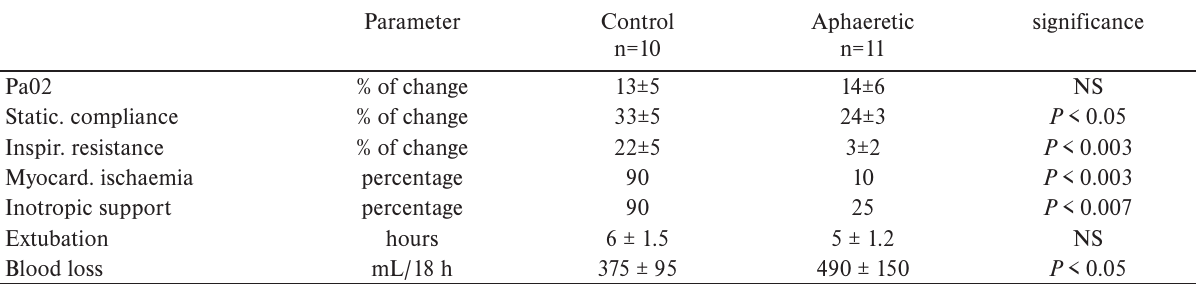
Table 3. early postop. data of